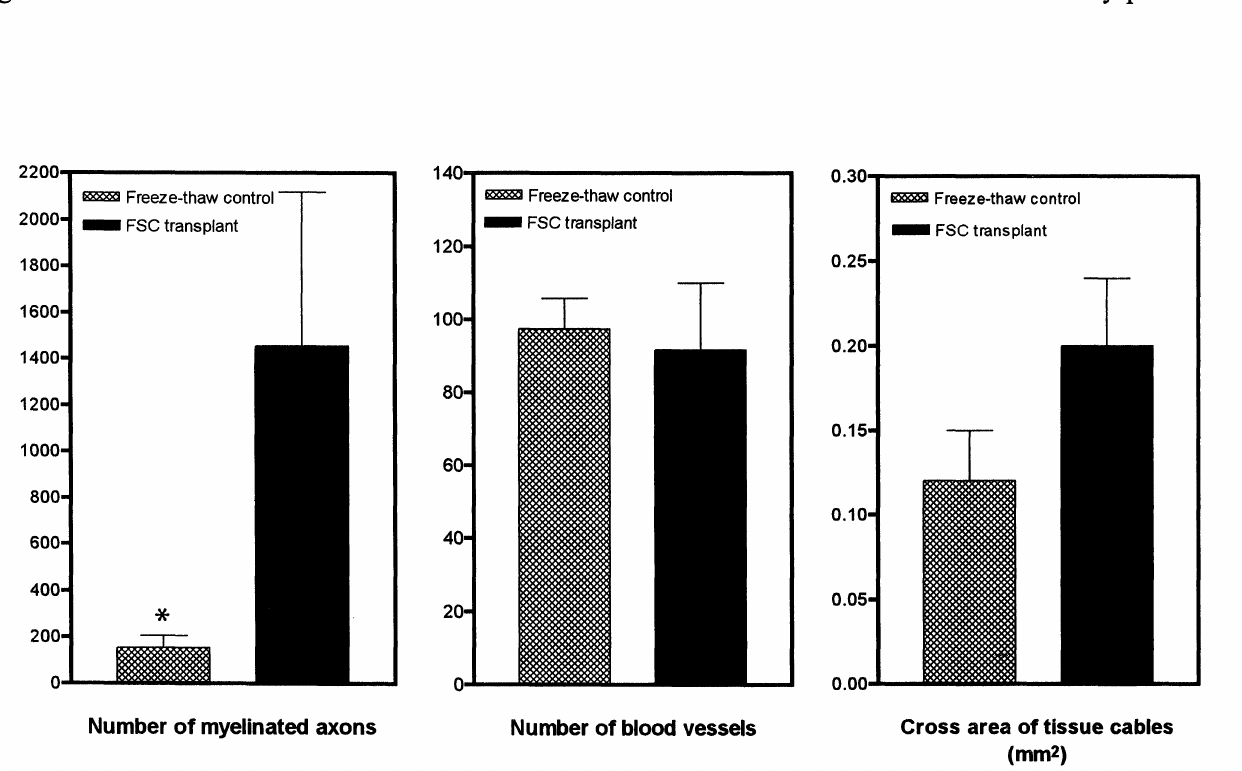
Fig. 5: Histograms showing the numbers of myelinated axons (left), blood vessels (middle), and cross sectional areas of tissue cables (right) in animals which received either FSC grafts (n=6; solid bar) or freeze-thaw control grafts (n=5; hatched bar). Means and standard errors are shown. Non-parametric analysis (Wilcoxon Rank Sum test) showed a statistical difference (P<0.01) between the numbers of myelinated axons in experimental and control groups